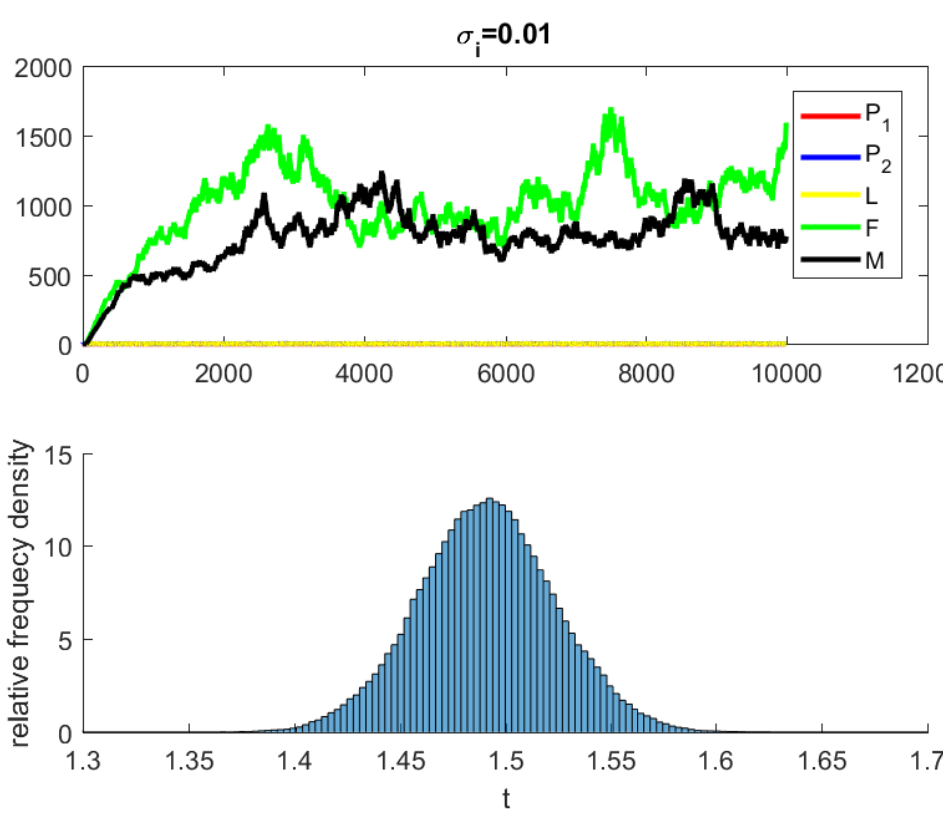
Figure 7. The stochastic system (2) and its histograms of probability density